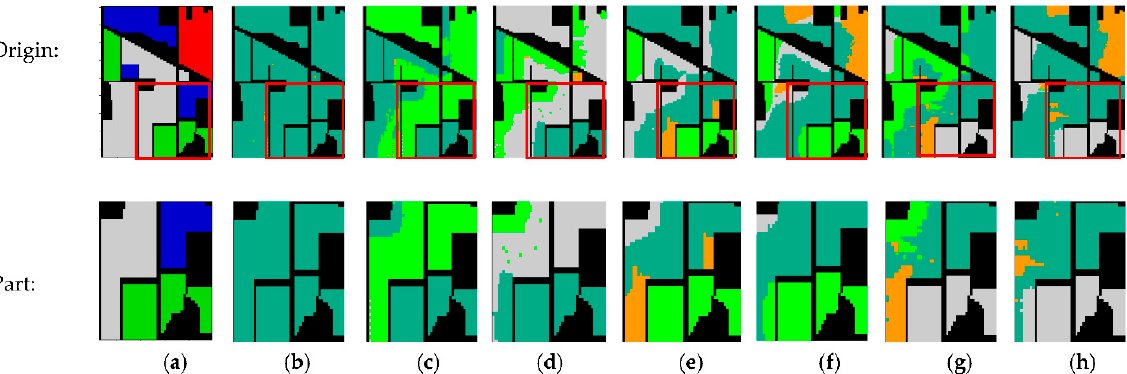
Figure 10. Clustering results obtained using different methods on the SalinasA data set with Gauss- ian noise. ( a ) Ground truth. ( b ) LRSC 35.96%. ( c ) SSC 47.61%. ( d ) S4C 54.77%. ( e ) EDSC 61.97%. ( f )